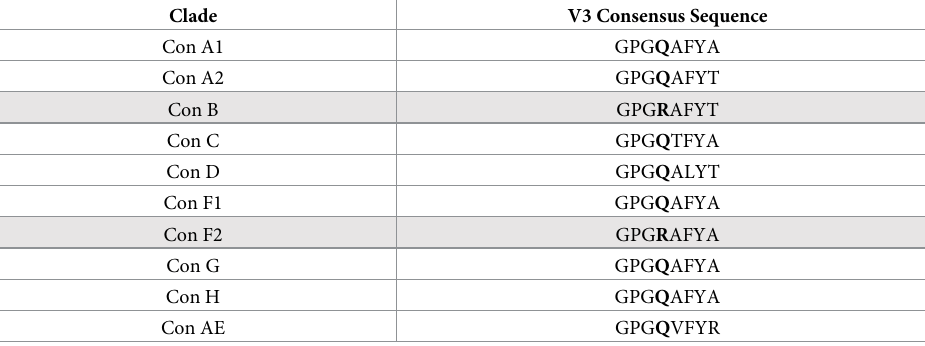
Table 3. V3 consensus